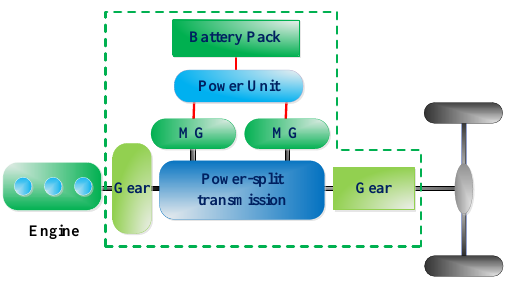
Figure 1. Configuration of power-split hybrid electric vehicle (HEV). MG: motor-generator.